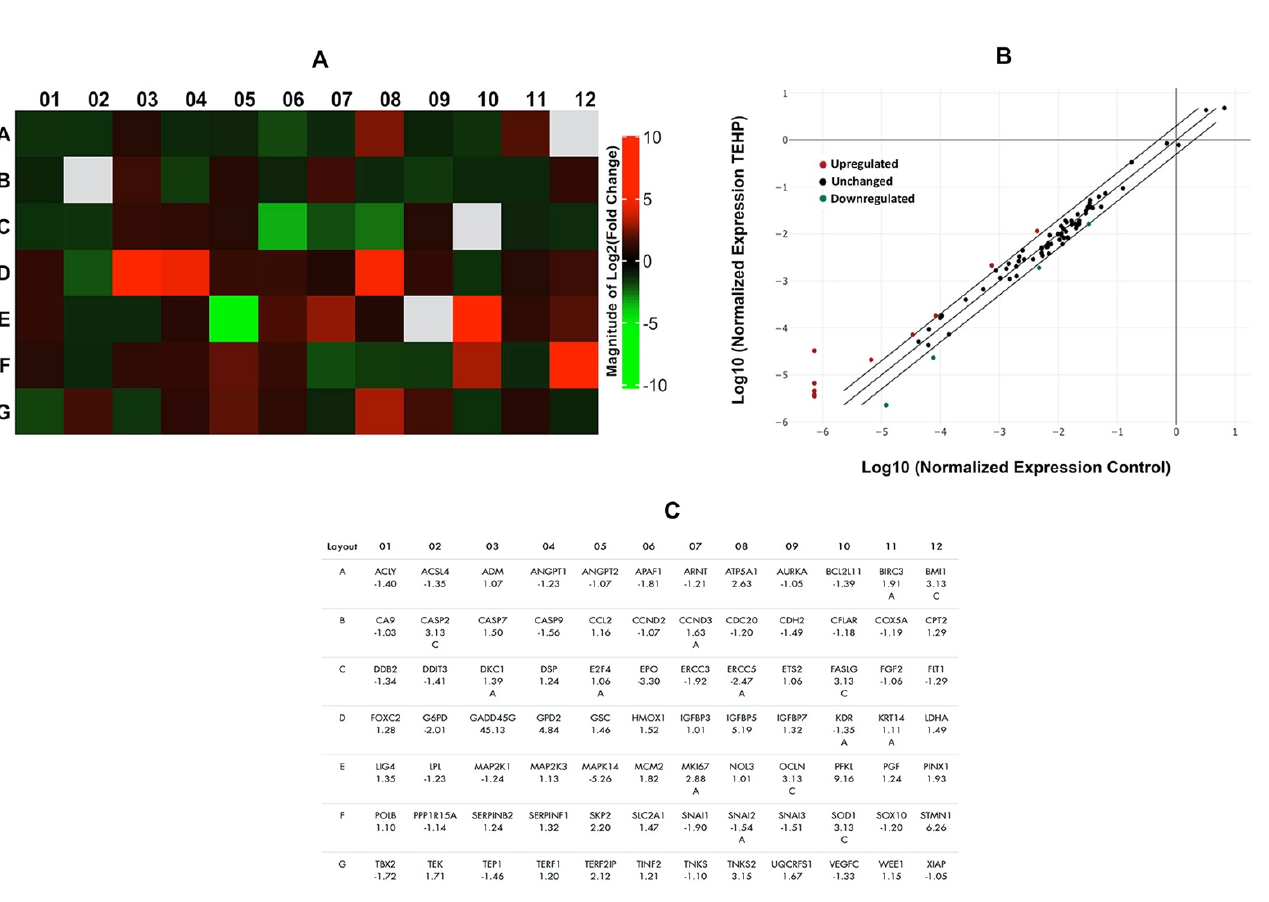
Figure 6. Transcriptomic changes in HepG2 cells after 72 h of TEHP (100 µM) exposure. ( A ) Heat map displaying upregulated (red boxes), downregulated (green boxes), and (gray boxes) undetermined genes in the array. ( B ) Genes that has exceeded the threshold of >2.0-fold regulation is shown in scatter plot. ( C ) Annotation of human cancer pathway genes, their location in array plate and fold regulation is depicted in the panel.